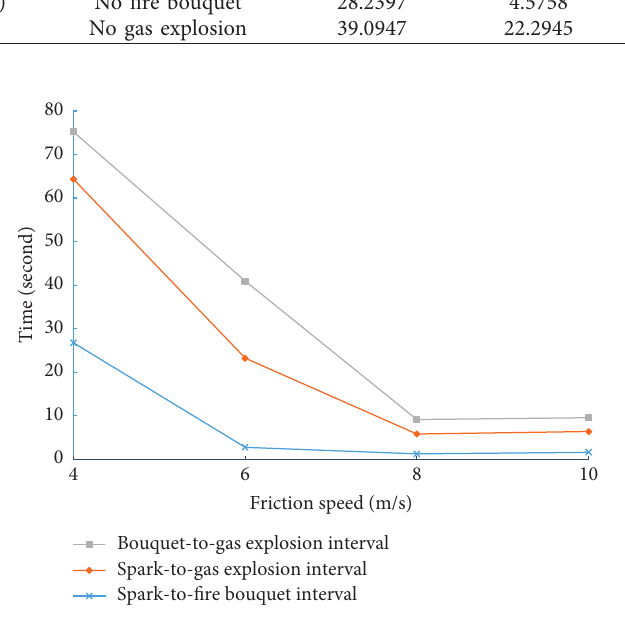
Figure 8: Time node information of typical test phenomena.